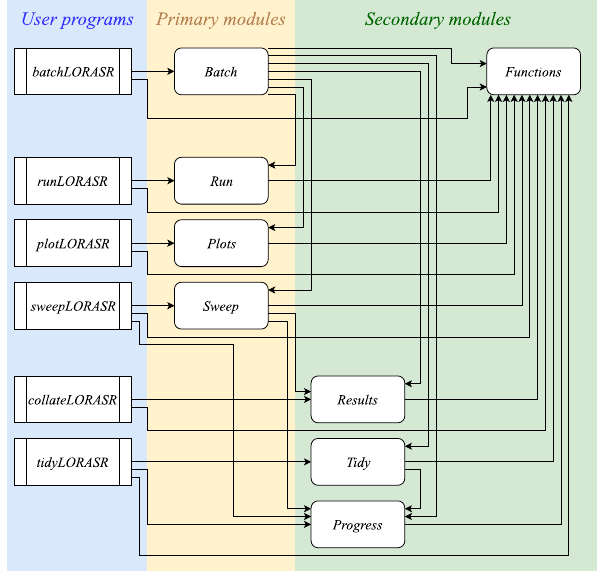
FIG. 2. Program structure of the RUNLORASR